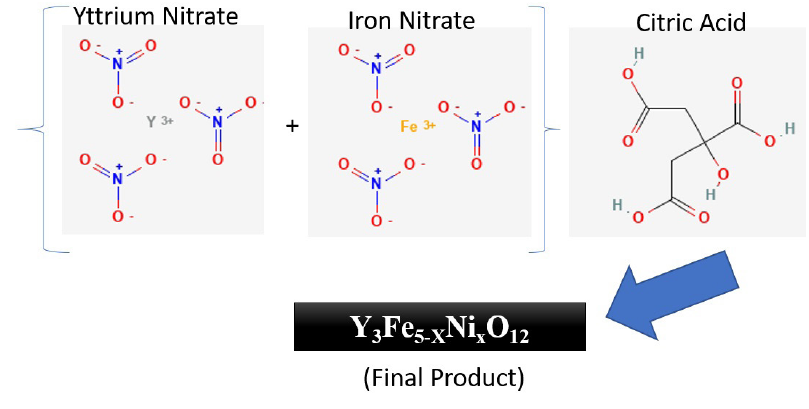
Figure 2. Schematic Diagram of Nitrate-Citrate Mechanism 18-20 .